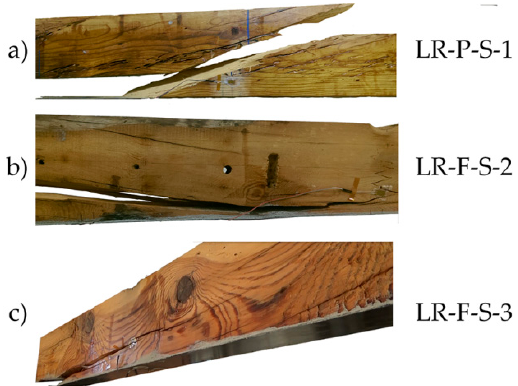
Figure 9. Breakage patterns of the LR beams group: ( a ) LR-P-S-1; ( b ) LR-F-S-2; and ( c ) LR-F-S-3. CFRP supplier: SIKA ® .